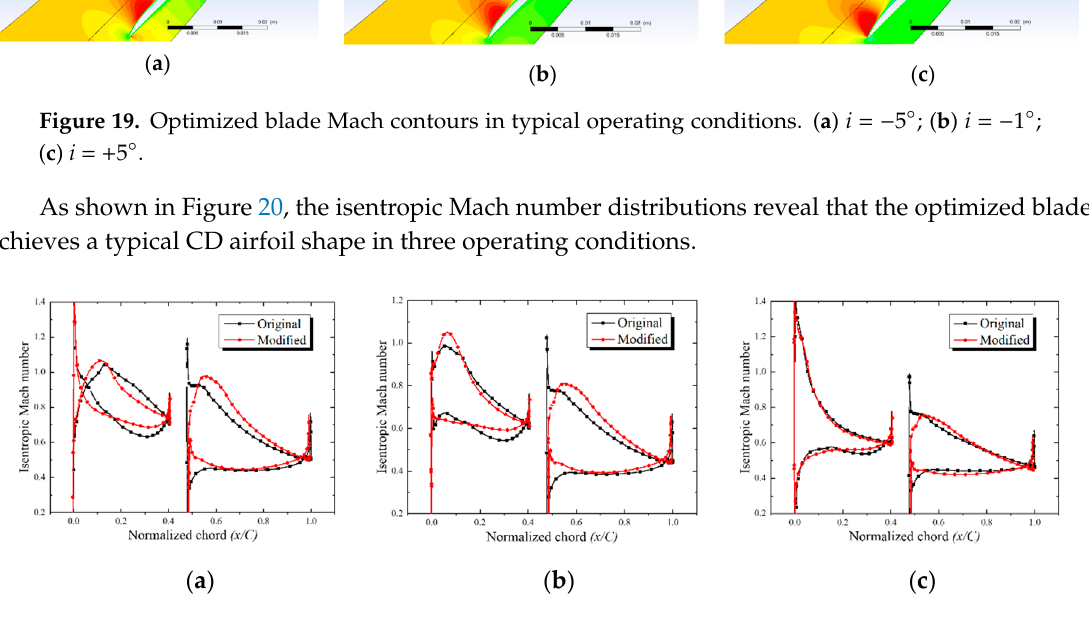
Figure 20. Comparison of the baseline and optimized blade surface isentropic Mach numbers. ( a ) i = − 5°; ( b ) i = − 1°; ( c ) i = +5°.